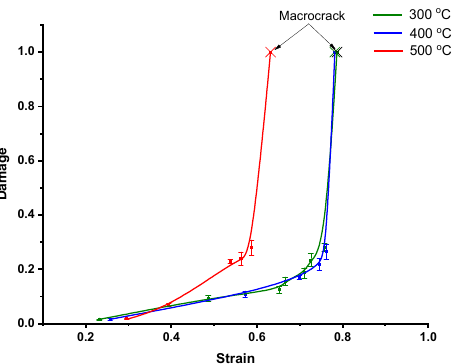
ε D for the V95\10% SiC MMC in Figure 12. The strain ( ) dependence of accumulated damage Figure 12. The strain ( ε ) dependence of accumulated damage D E for the V95 \ 10% SiC MMC in the E zone near the side surface at 300, 400, and 500 ◦ C (see Figure the zone near the side surface at 300, 400, and 500 °C (see Figure 2).